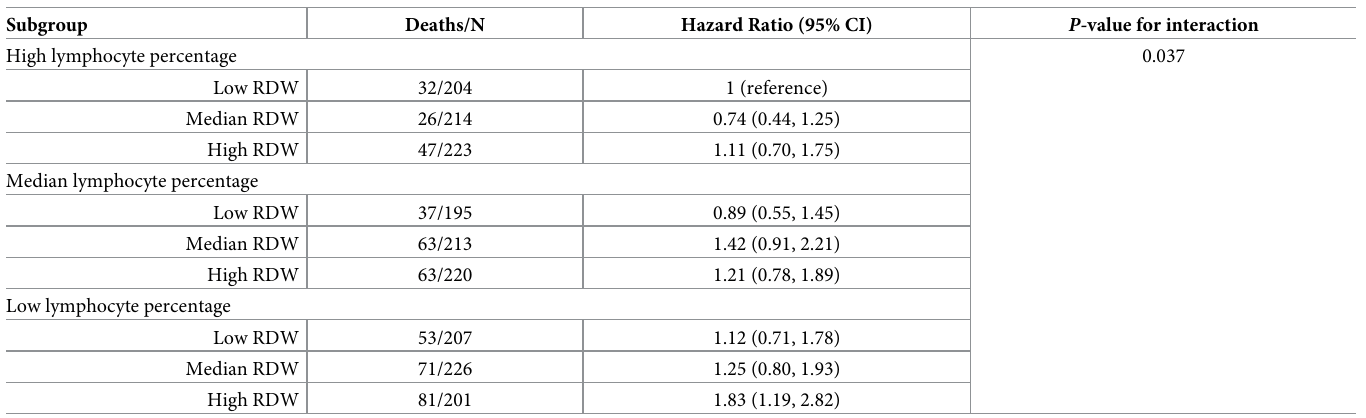
Table 3. Risk of In-hospital mortality according to lymphocyte percentage and RDW level. Subgroup